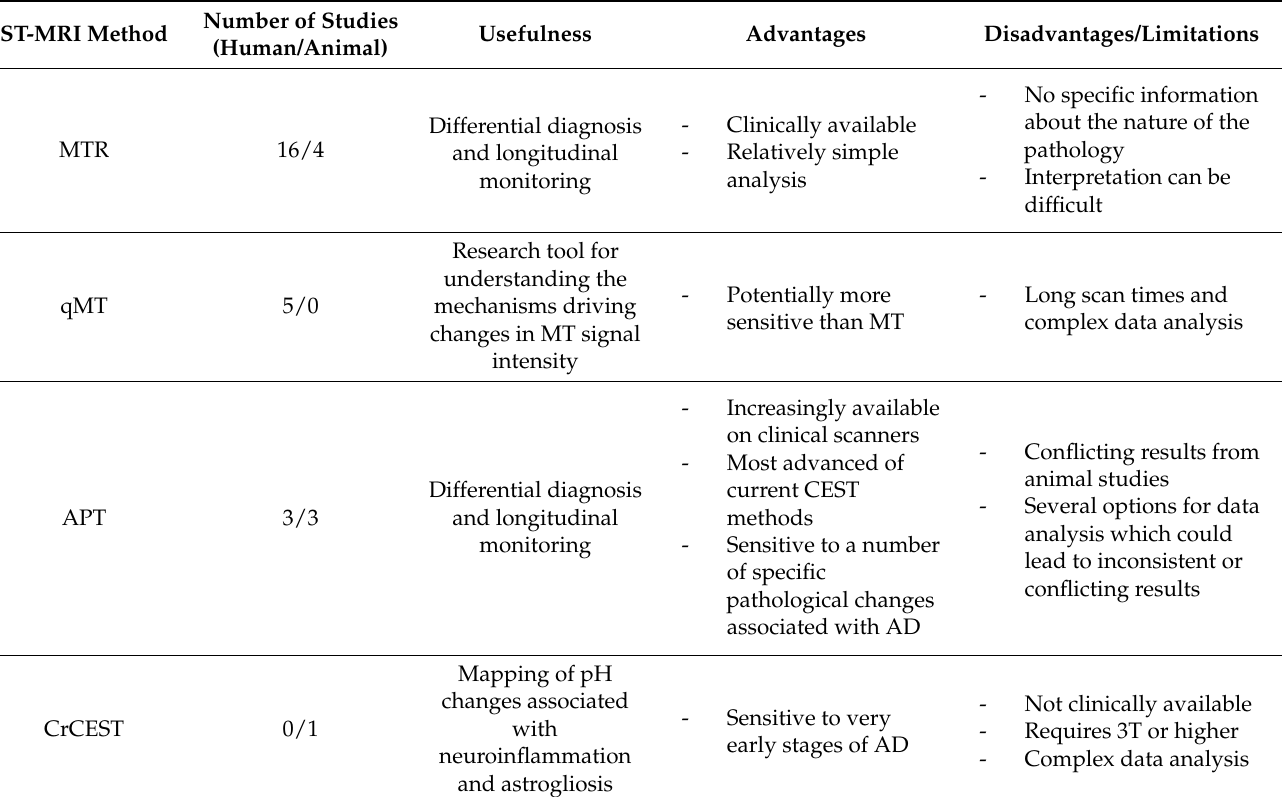
Table 7. Summary of the revised saturation transfer MRI techniques with their potential usefulness in diagnosis and management of the pathology, their major advantages, and